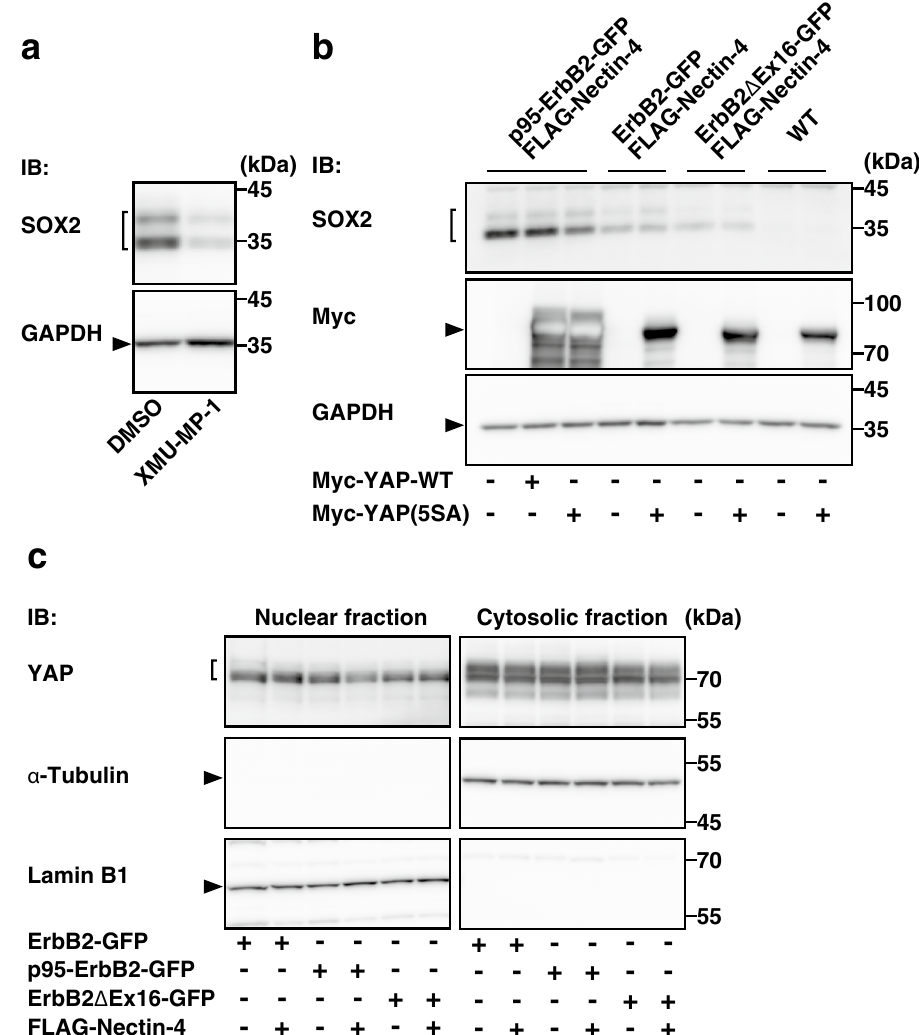
Figure 5. Hippo signaling-dependent SOX2 gene expression by nectin-4 and p95-ErbB2 in T47D cells in an adherent culture. ( a ) Requirement of the MST1/2 activation for the increase in the amount of the SOX2 protein by nectin-4 and p95-ErbB2 in T47D cells in an adherent culture. The T47D cells stably expressing GFP-tagged p95-ErbB2 (p95-ErbB2-GFP) with FLAG-tagged nectin-4 (FLAG-Nectin-4) were cultured for 48 h. The cells were then treated with the MST1/2 inhibitor XMU-MP-1 at 1 μM for 24 h. The cells were subjected to Western blotting using the indicated Abs. ( b ) Decrease by a constitutively active YAP in the amount of the SOX2 protein increased by nectin-4 and p95-ErbB2 in T47D cells in an adherent culture. The T47D cells stably expressing GFP-tagged ErbB2 or each of its splice variants with FLAG-Nectin-4 were transfected with Myc-tagged YAP wild-type (Myc-YAP-WT) or Myc-tagged YAP(5SA) mutant (Myc-YAP(5SA)). The cells were then cultured for 72 h in an adherent culture. The cells were subjected to Western blotting using the indicated Abs. ( c ) Decrease in the amount of the YAP protein in the nuclear fraction by nectin-4 and p95-ErbB2 in T47D cells in an adherent culture. The nuclear and cytosolic fractions were prepared from the T47D cells stably expressing GFP-tagged ErbB2 or each of its splice variants with or without FLAG-Nectin-4. Each fraction was subjected to SDS-PAGE followed by Western blotting using the indicated Abs. All the cell lines used in the experiments were the bulk of collected cells and not singly picked-up clones. Arrowheads and square brackets indicate each of the proteins. The displayed blots were cropped, and the full-length blots are shown in Supplementary Figure S6a–c. IB, immunoblotting. Representative results (images) from three independent experiments were